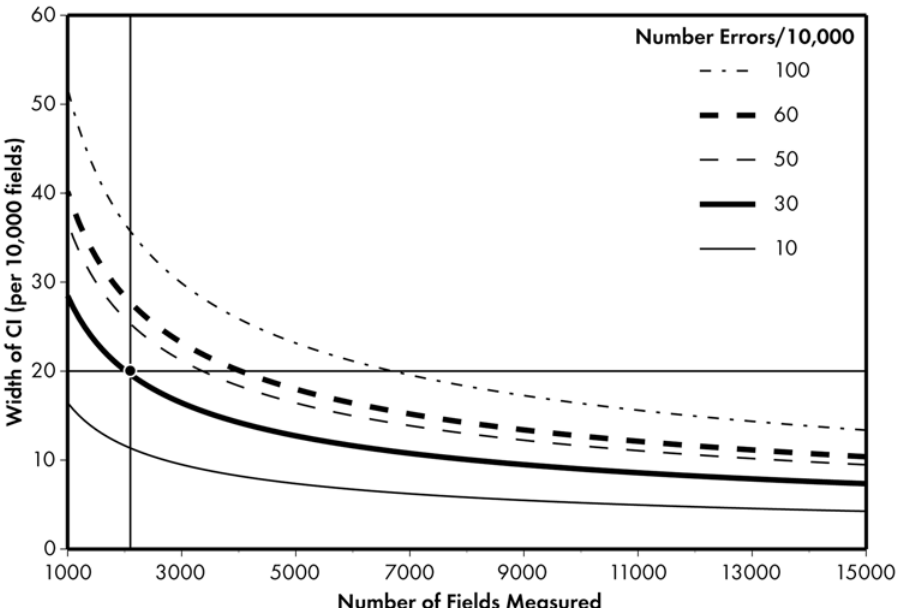
Figure 1. Sample size curves: 95% confidence intervals (Formula 1), one-tailed. Intersection of vertical and horizontal lines shows sample size needed to achieve a one-sided CI given an acceptance criterion of 50 errors per 10,000 data fields, an underlying expected error rate of 30 errors per 10,000 fields, and a desired CI width of 20 errors per 10,000 fields (Fleiss J, Levin BL, Paik M. Statistical Methods for Rates and Proportions. 3 rd ed. New York, NY: Wiley; 2003).